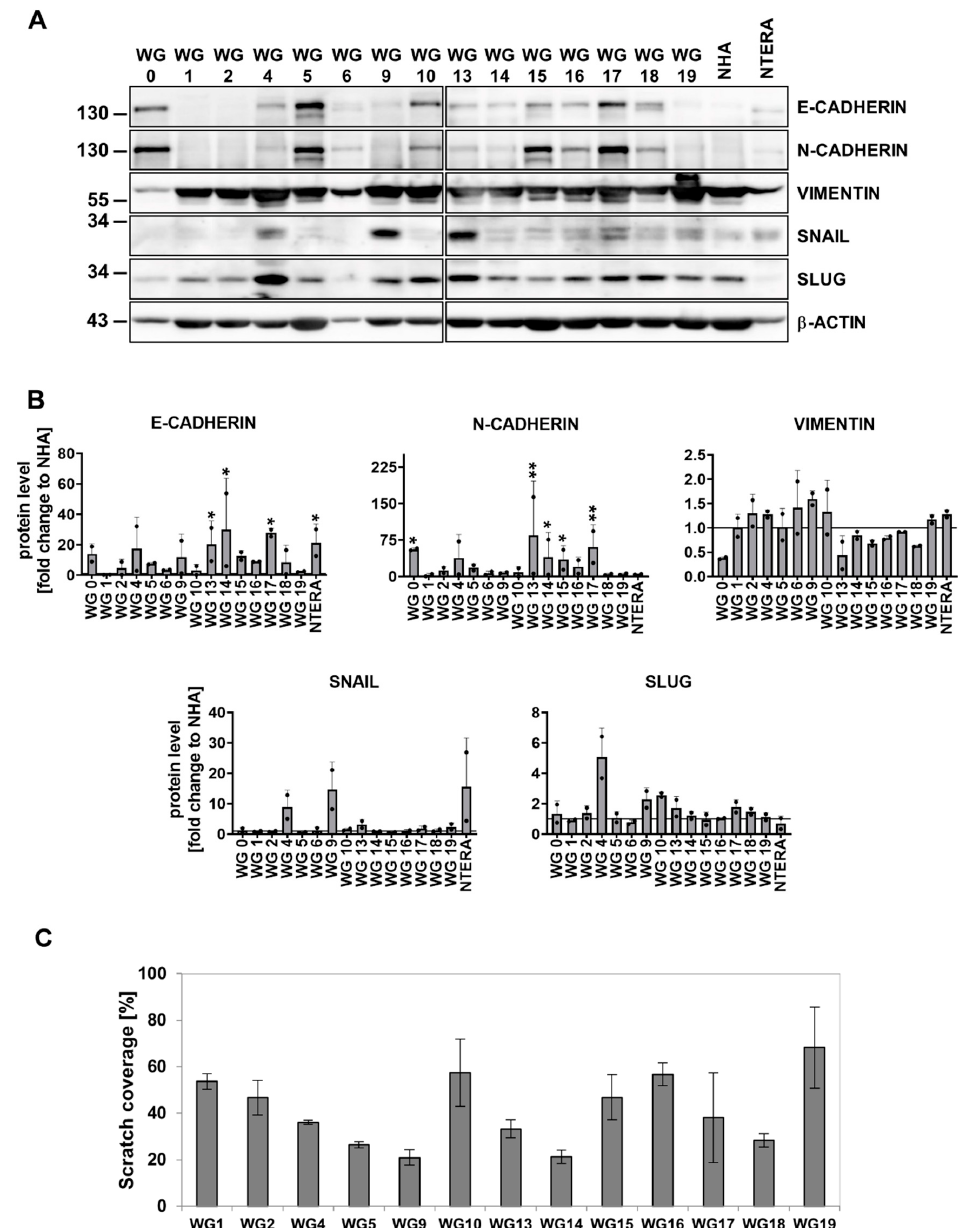
Figure 4. Epithelial mesenchymal transition (EMT) related genes and proteins in human primary glioma cell cultures. ( A ) Representative immunoblots showing the EMT markers levels in glioma primary cultures, NHA and NTERA cells. ( B ) Quantification of immunoblots. The level of a protein of interest in NHA cells equals 1 and is marked by a solid black line. β -ACTIN was used as a loading control. Statistical analysis was performed using one way ANOVA with Dunnett’s post hoc test comparing values obtained in tumor cells to NHA cells (* p < 0.05, ** p < 0.01,), n = 2, mean ± SD. ( C ) Quantification of glioma cell migration using an in vitro scratch assay. Results are presented as the percentage of scratch coverage after 18 h, n = 3, mean ± SD. The whole blots and molecular weight markers are shown in Supplementary Figure S11.